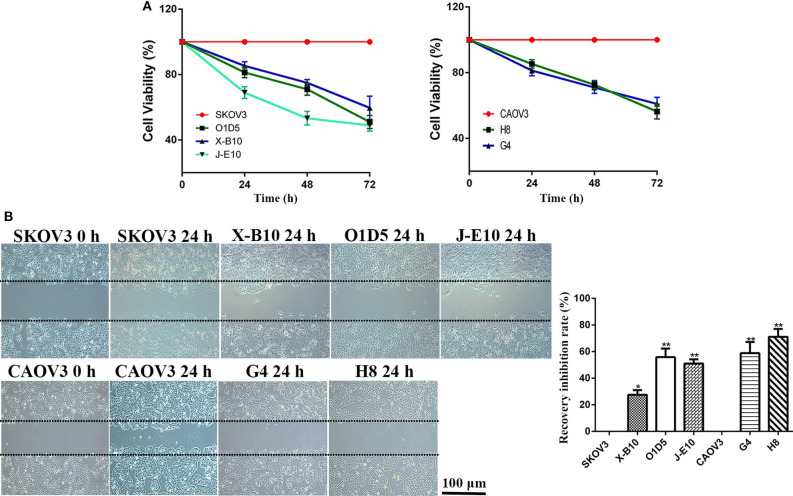
OC-2 KO inhibited the cell viability of SKOV3 and CAOV3 cells. (A) Cells were cultured for the indicated time (0–72 h) and the cell viability was analyzed by CCK8 assay. (B) The monolayer cells were scraped in a straight line and the recovery of scratches was photographed at 24 h. The blank areas were measured by ImageJ software. Left panel, representative images. Right panel, statistical analysis of recovery data. Scale bars, 100 μm. *P < 0.05, **P < 0.01.